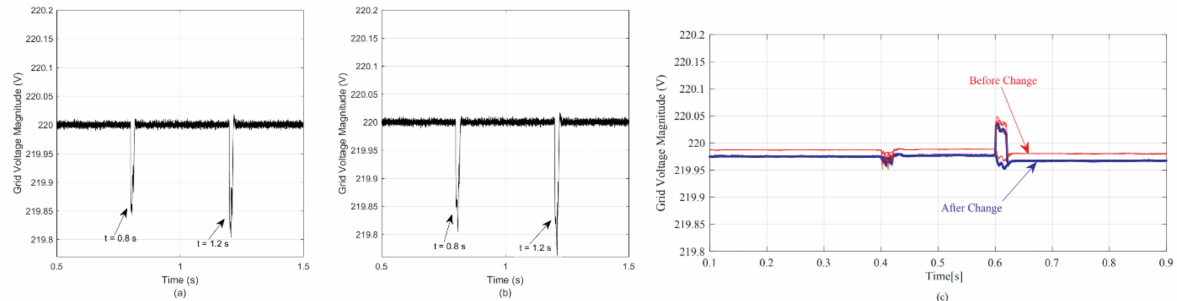
Figure 13. The grid voltage magnitudes under two different sets of MG parameters, ( a ) phase a voltage magnitude under the first set, ( b ) phase a voltage magnitude under the second set, ( c ) three-phase voltage magnitudes under two different sets of MG parameters in ref [19].